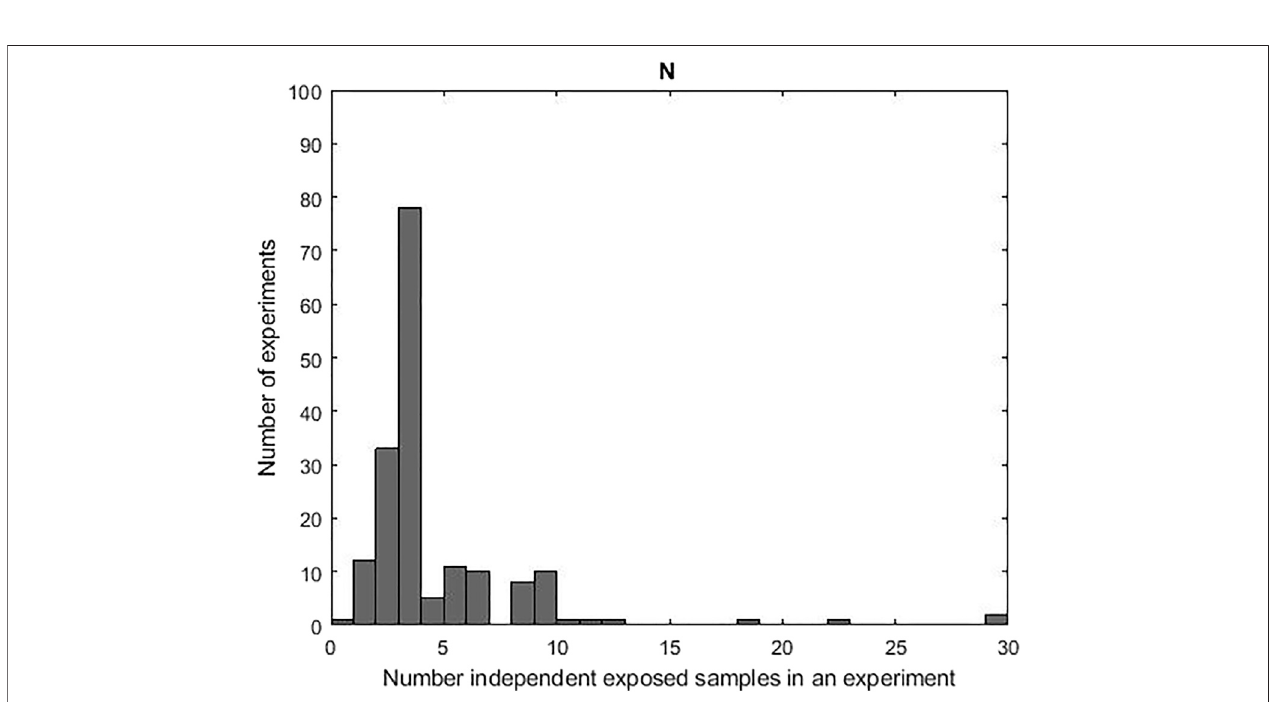
FIGURE 1 | Distribution of size of exposed and control groups (typically equal) for the 175 experiments over 31 studies. The numbers refer to the number of statistically independent samples representing different exposures to animals (not to numbers of cells from individual animals scored by investigators).